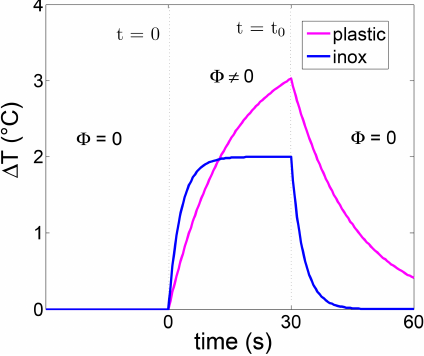
Figure 5. Gas sensitivity of catalyst A exposed to different H 2 con- centrations in dry air at room